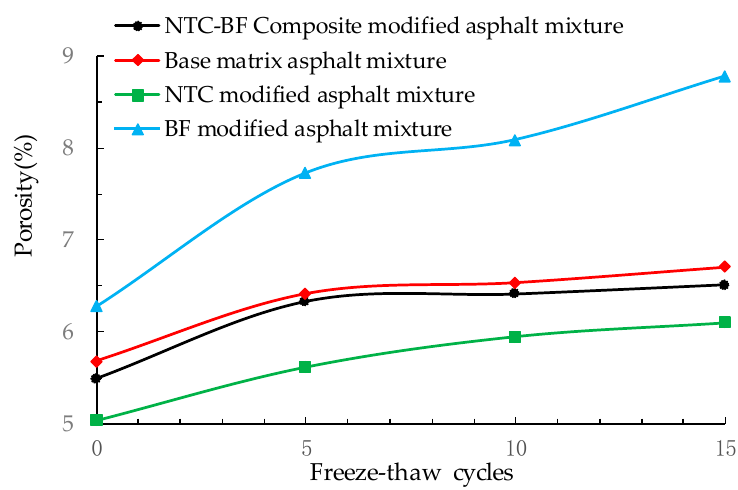
Figure 12. Variation of porosity after test F–T cycles of test asphalt mixture.